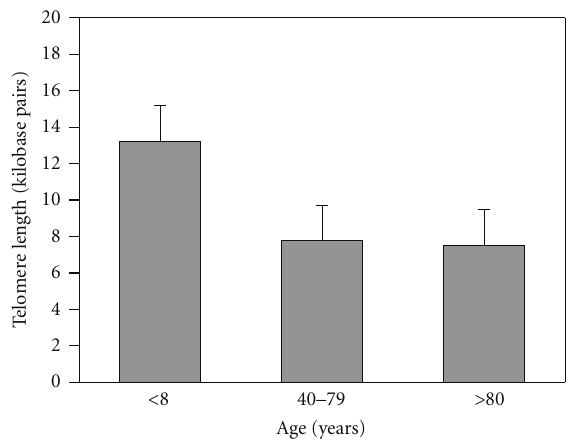
Figure 3: E ff ect of aging on telomere length in human hepatocytes. Both Takubo et al. and Aikata et al. (not shown) determined hepatocyte telomere length to be between 5–10 kbp in humans 80 years of age. Data derived from [26,